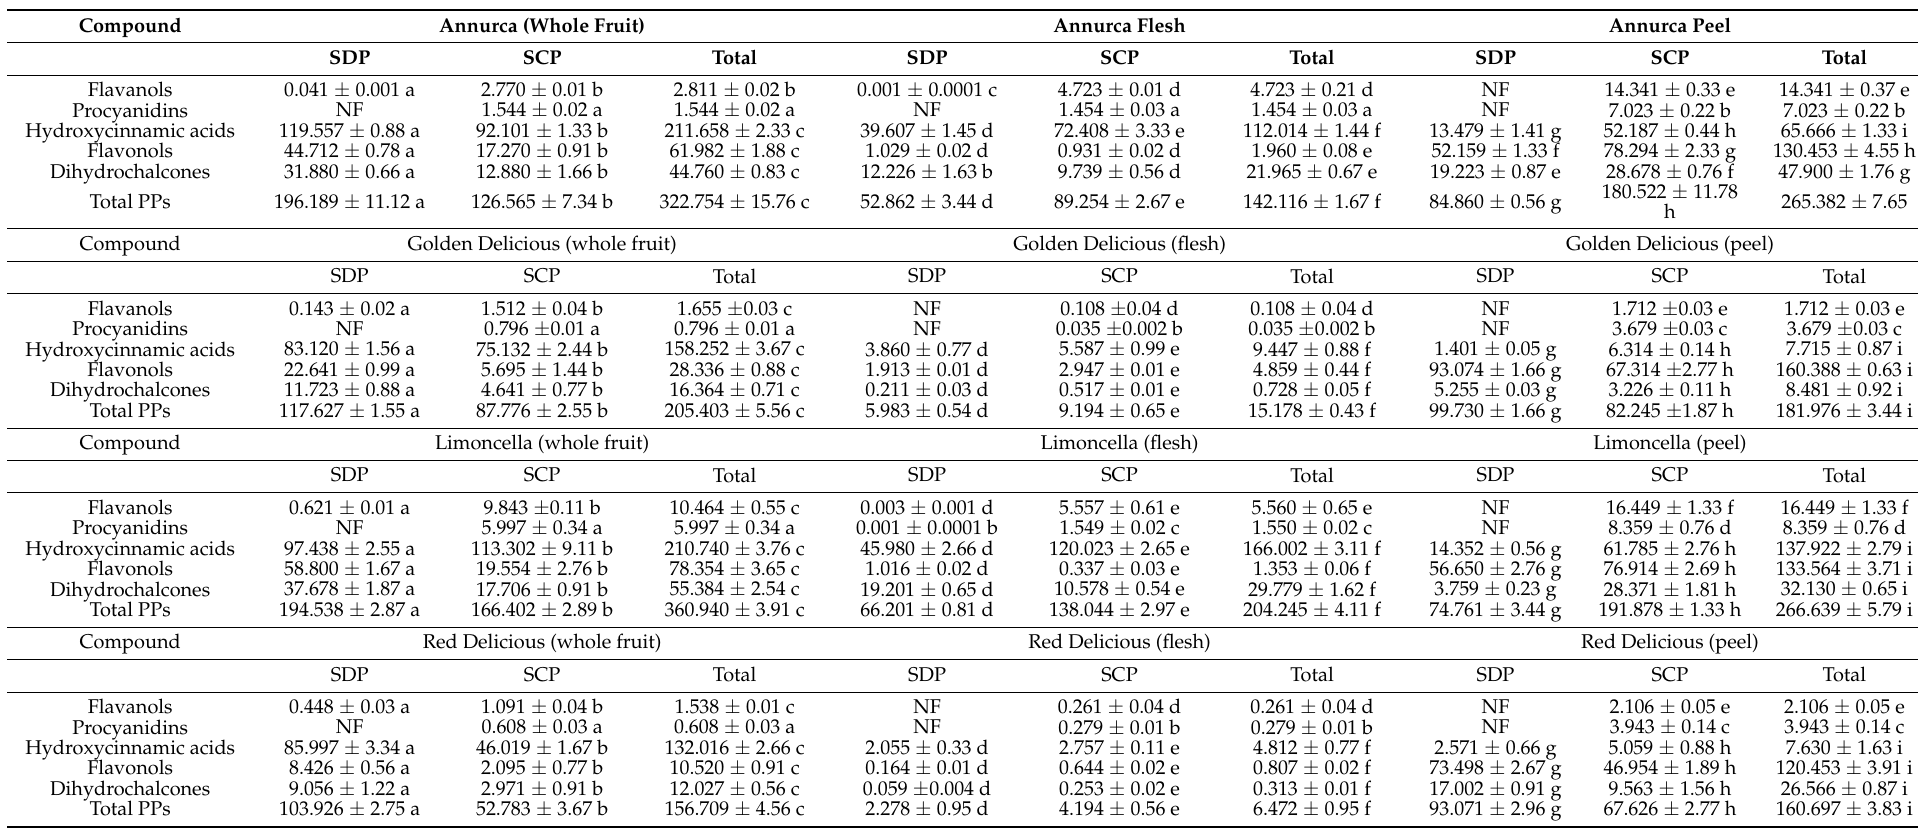
Table 6. Concentrations of polyphenols released upon in vitro digestion of apple sample (flesh, peel, and whole fruit). Polyphenols were detected by HRMS-Orbitrap and values are expressed in µ g/g (dw). Each value represents the mean ± SD of three replicates. For each line, different letters indicate significantly different values ( p < 0.05) according to Tukey’s test. NF: not